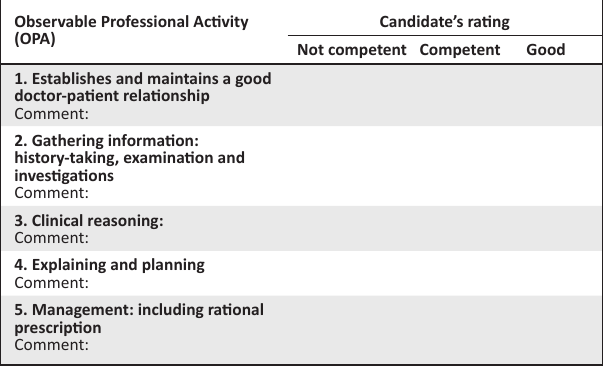
FIGURE 2: Marking sheet for consultation